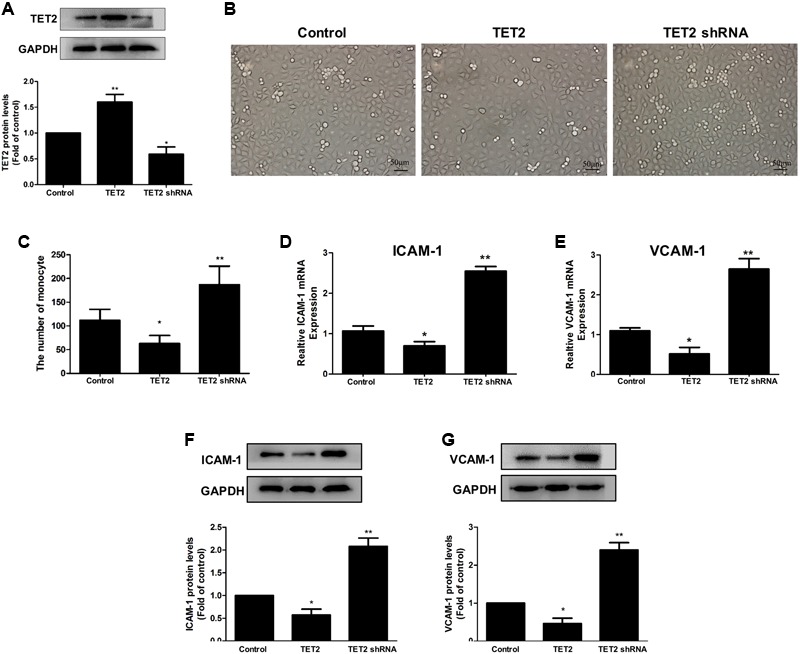
Effects of TET2 on the oxLDL-induced dysfunction of HUVECs. (A) The effects of TET2 overexpression and shRNA plasmids on TET2 protein expression in HUVECs. (B,C) HUVECs were transduced with TET2 overexpression plasmid or TET2 shRNA plasmid, then treated with 75 μg/ml oxLDL for 24 h. THP-1 cells were seeded onto HUVECs and co-cultured for 30 min. After washing the non-adherent cells, adherent cells were detected and counted under a light microscope. Representative light microscopic pictures of THP-1 cell adhesion to oxLDL-activated HUVECs (B) and quantitative analysis of adhesion results (C). Data are the mean ± SEM of results from at least three independent experiments, each performed in duplicate. ∗P < 0.05, ∗∗P < 0.01 vs. control (treated with oxLDL alone) group. (D–G) The mRNA and protein levels of ICAM-1 and VCAM-1 in oxLDL-treated HUVECs with TET2 overexpression or TET2 silencing were determined by real-time PCR and western blot analyses. All results are expressed as the mean ± SD of three independent experiments, ∗P < 0.05, ∗∗P < 0.01 vs. control (treated with oxLDL alone) group. All results are expressed as the mean ± SD of three independent experiments, ∗P < 0.05, ∗∗P < 0.01 vs. control group.